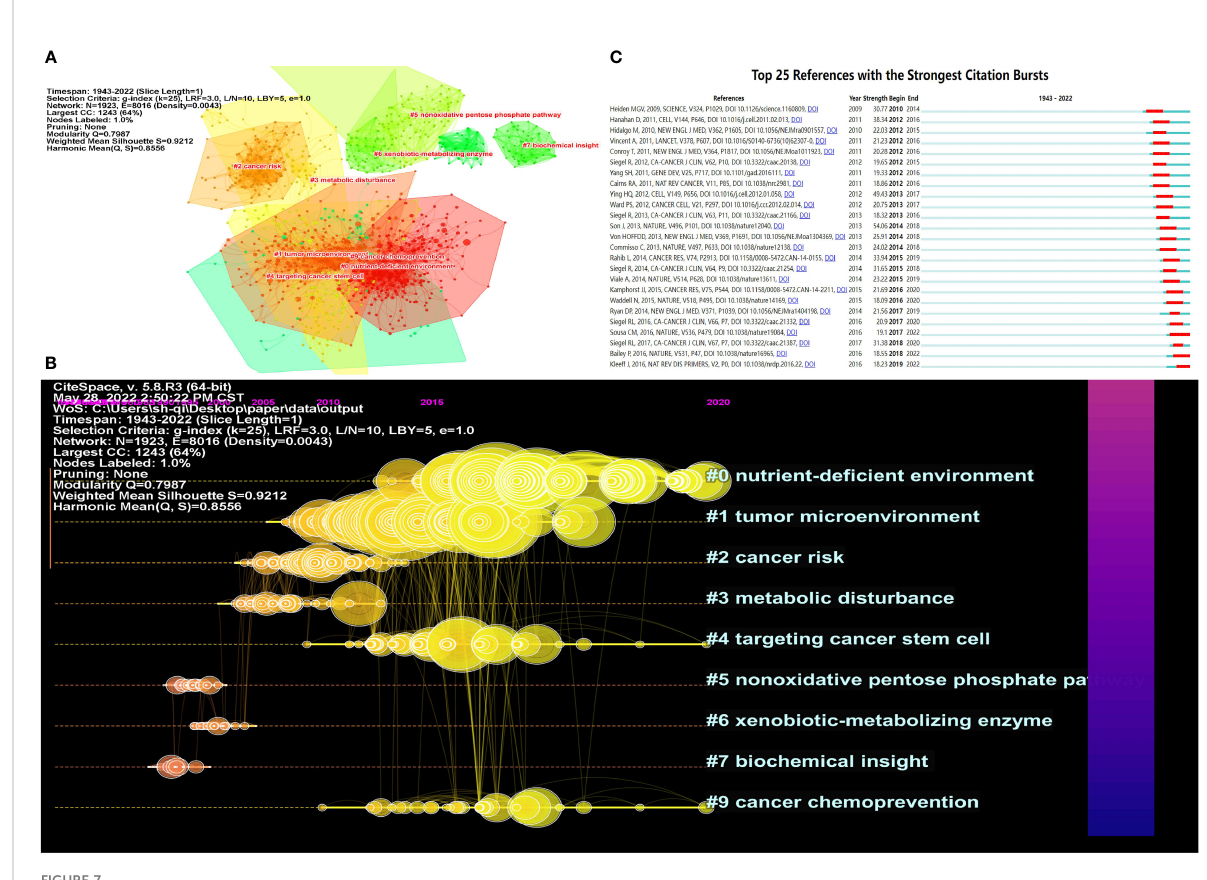
FIGURE 7 Visualization of co-cited references analysis. (A) Cluster analysis of co-cited References; (B) The top 10 kinds of literature with the highest number of citations; (C) Top 25 references with the strongest citation